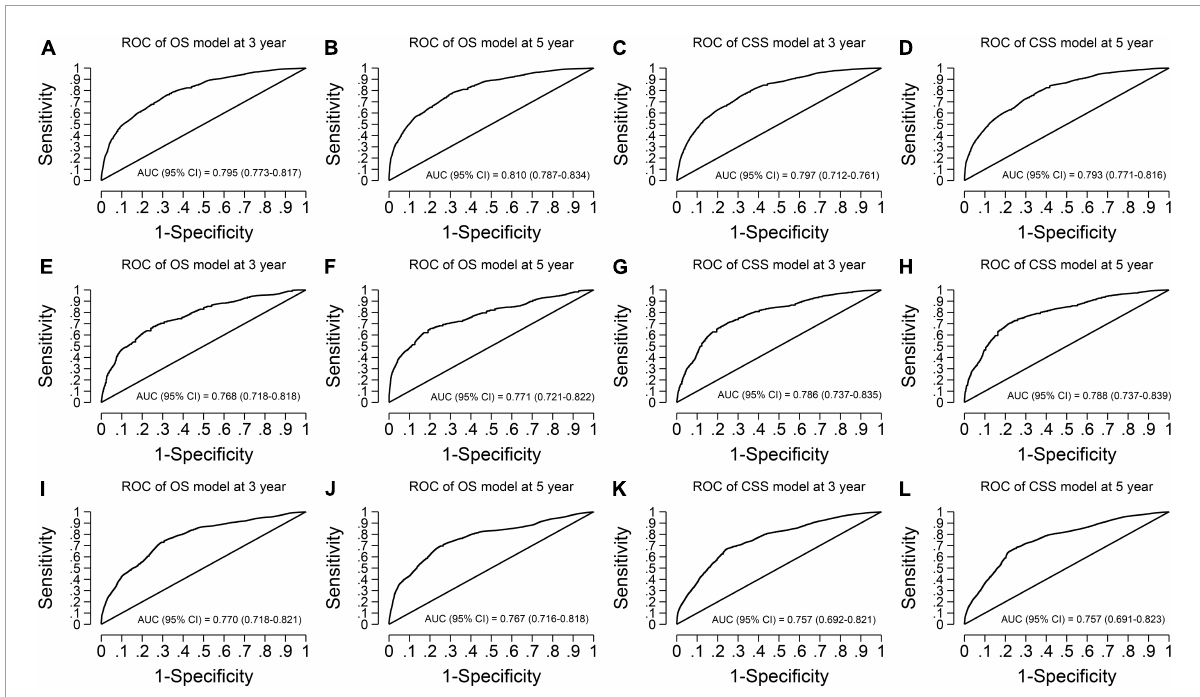
FIGURE4 Time-dependent receiver operating characteristic curves of the final overall survival (OS) and cancer-specific survival (CSS) models. (A,B) OS model in the imputed training cohort with AUCs of 0.795 and 0.810 at 3- and 5-year survival time, respectively. (C,D) CSS model in the imputed training cohort with AUCs of 0.797 and 0.793 at 3- and 5-year survival time, respectively. (E,F) OS model in the complete cases of the validation cohort with AUCs of 0.768 and 0.771 at 3- and 5-year survival time, respectively. (G,H) CSS model in the complete cases of the validation cohort with AUCs of 0.786 and 0.788 at 3- and 5-year survival time, respectively. (I,J) OS model in the imputed validation cohort with AUCs of 0.770 and 0.767 at 3- and 5-year survival time, respectively. (K,L) CSS model in the imputed validation cohort with AUCs of 0.757 and 0.757 at 3- and 5-year survival time, respectively. The receiver operating characteristic curves show our models have good discrimination ability in predicting the 3- and 5-year survival of vaginal cancer patients. AUC, area under the receiver operating characteristic curve.